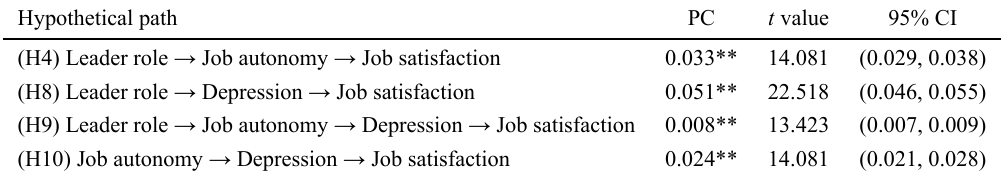
Table 5. Results of hypotheses testing on the mediating effects in regular employees.